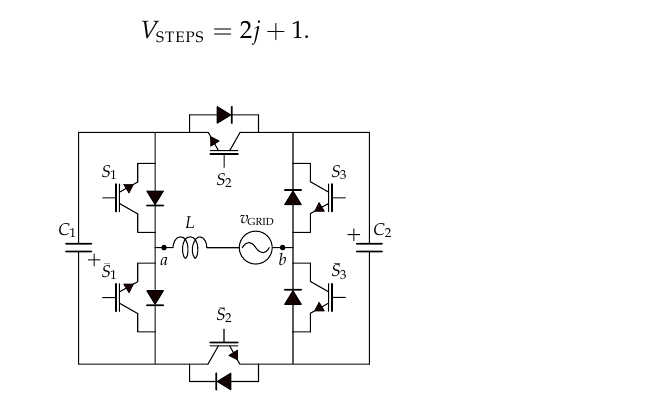
Figure 1. Basic structure of five-level cross-connected half-bridges ( CCHB ) multilevel inverter.